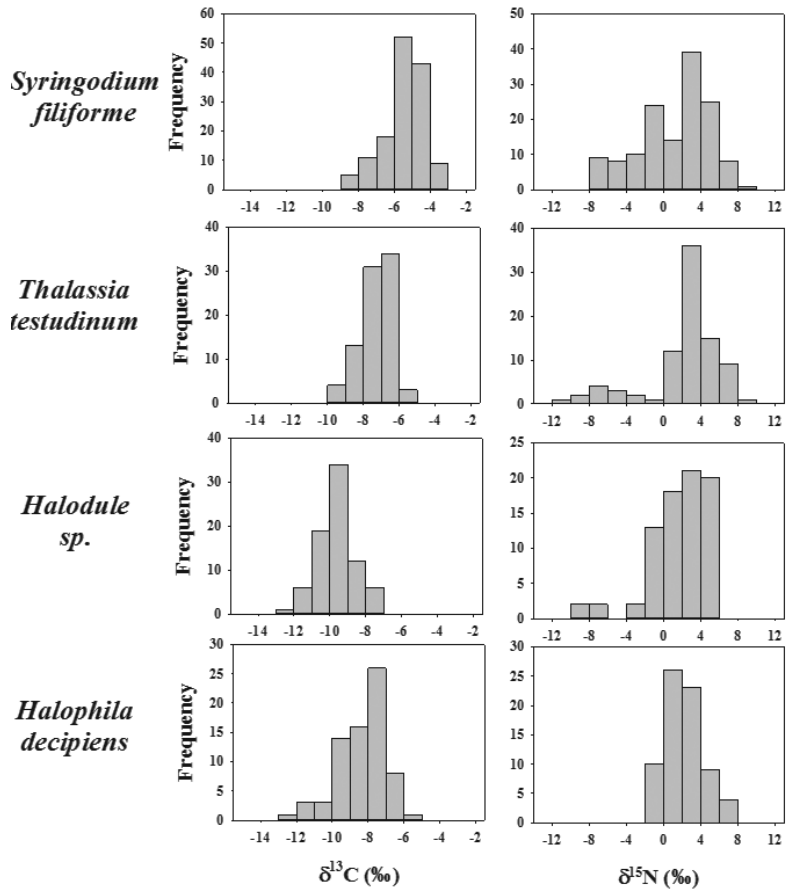
Figure 5. Frequency distribution of the measured δ 13 C and δ 15 N of seagrasses collected on the Bermuda Platform, by species.